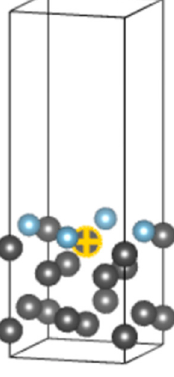
Figure 8. The selected Pu atoms for DOS analysis. (The blue spheres represent aluminum atoms, the grey spheres represent plutonium atoms, the selected one is in yellow).